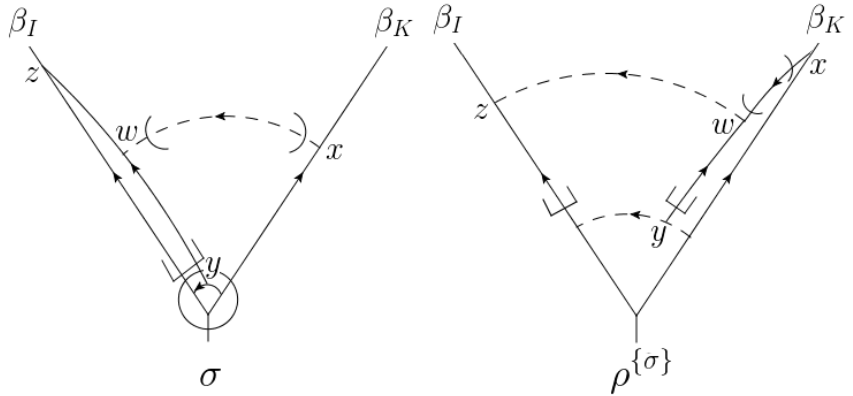
Figure 47. The position-space version of soft-exotic con(cid:12)gurations.